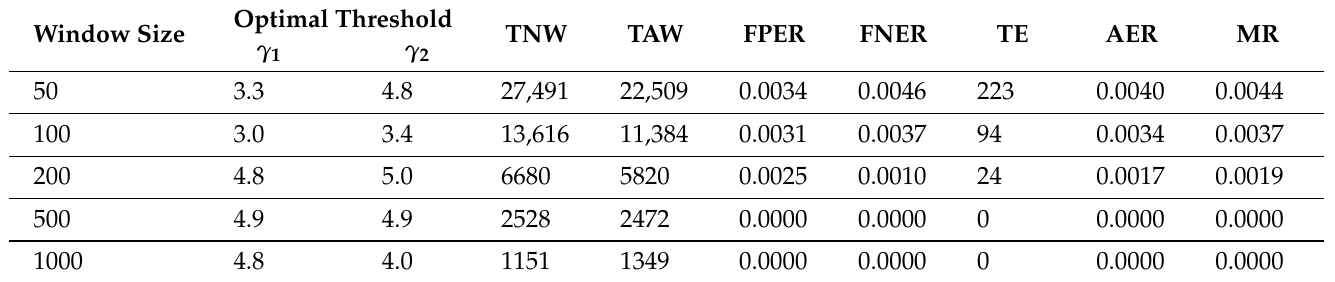
Table 10. Performance evaluation using optimum threshold value (fuzzy